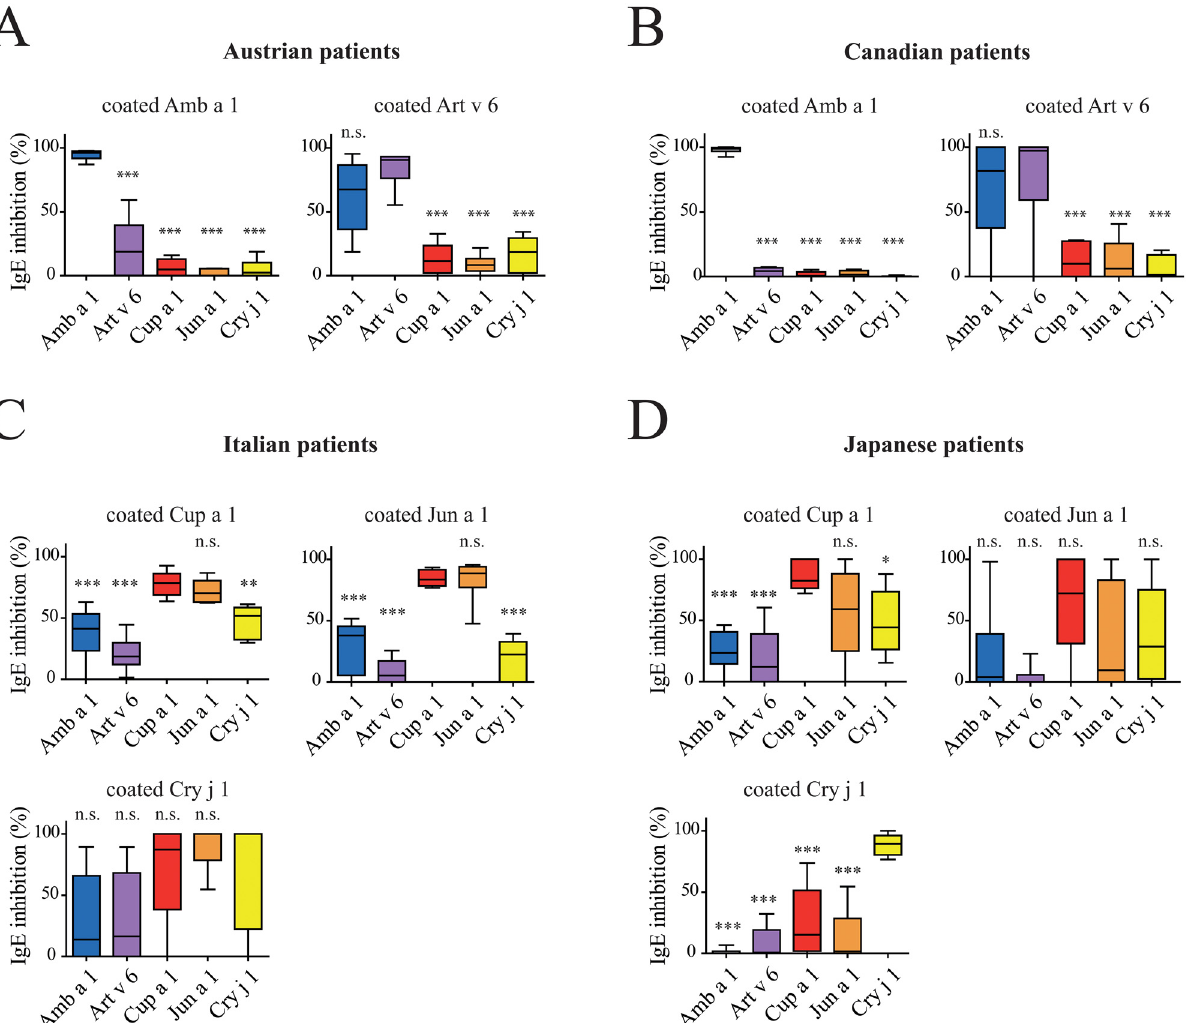
Fig 4. Inhibition ELISA of allergic patients´ sera. IgE binding of sera of pectate lyase pollen allergic patients from Austria (n = 6) and Canada (n = 6) were tested with coated Amb a 1 and Art v 6, respectively, sera from Italian (n = 6) and Japanese (n = 6) patients were tested with coated Cup a 1, Jun a 1, and Cry j 1. Prior to the ELISA all sera were pre-incubated with either 1 μ g/ well of Amb a 1, Art v 6, Cup a 1, Jun a 1, or Cry j 1. Inhibitions are presented as box plots, median values are indicated as lines, whiskers indicate the 5 – 95 percentile. Results are presented as % inhibition compared to maximum IgE of untreated sera. Statistical analysis was performed with Repeated Measures ANOVA and Tukey´s Multiple Comparison Test ( * P < .05, ** P < .01, *** P <